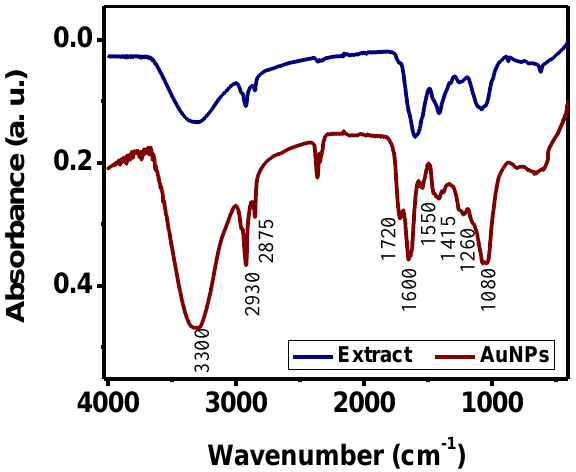
Figure 5. FTIR analysis of water/ethanol Sargassum spp. extract and AuNPs.